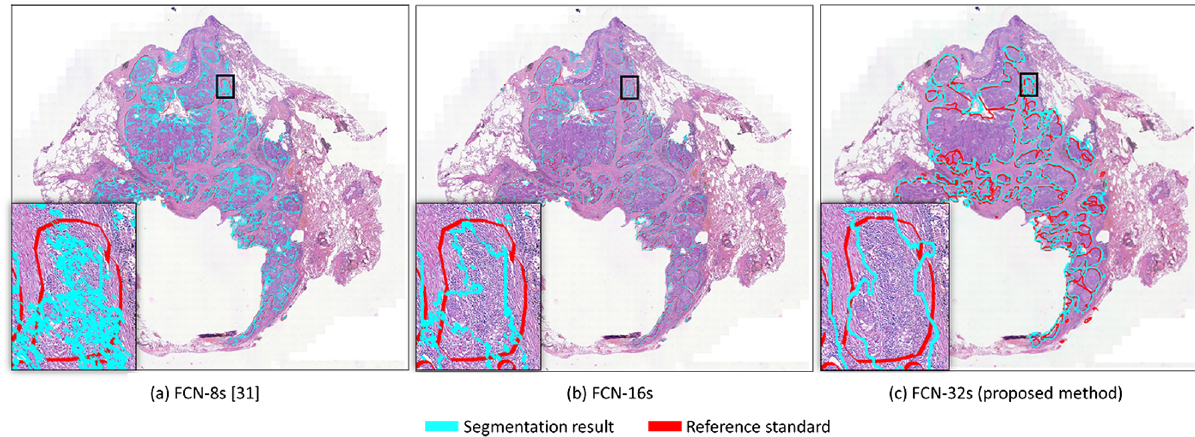
Figure 6. Comparison of segmentation results of three un-sampling layers of FCN. The results of ( a ) FCN-8s, and ( b ) FCN-16s are too fragmented. ( c ) In comparison, the results of FCN-32s are the most similar to reference